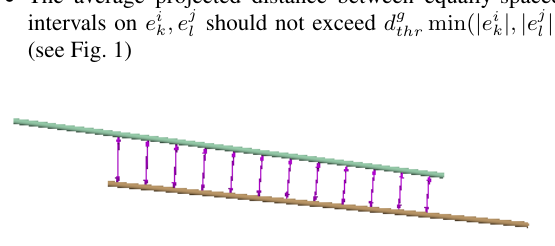
Figure 1. Distance betwen equidistant points on the first line, and their projections on the second line.